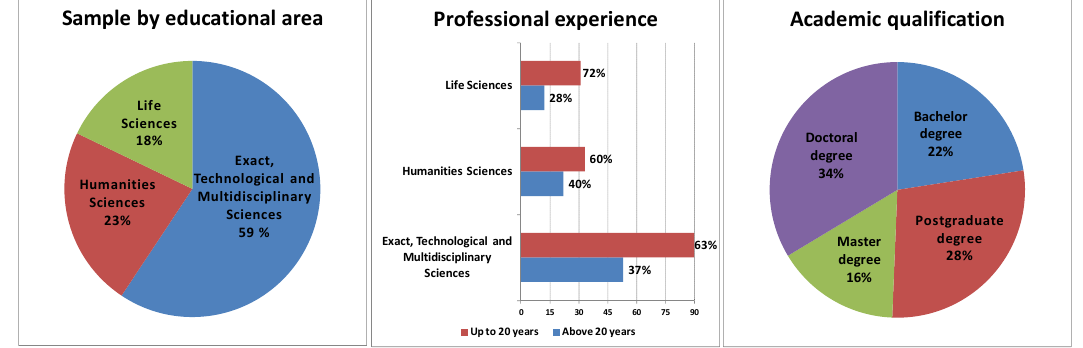
Figure 3. Interviewees’ profile